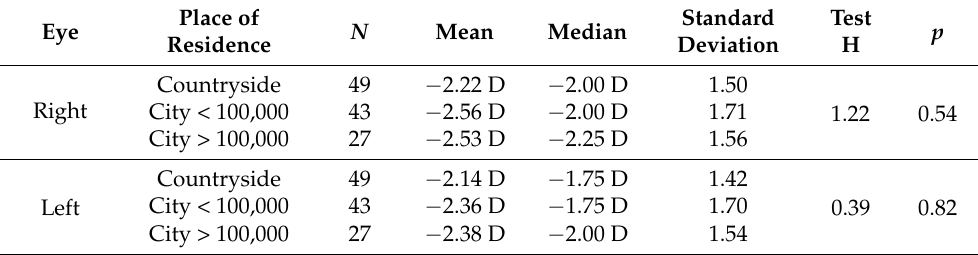
Table 3. Refractive error in myopic students depends on their place of residence in childhood and early adolescence.